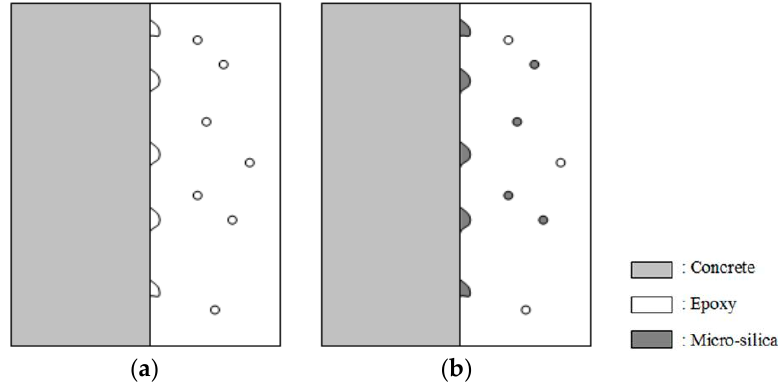
Figure 18. Pore reduction by MSAE; ( a ) non-MS; and ( b ) MSAE.